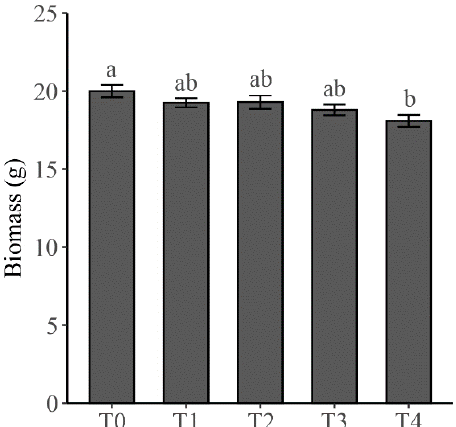
Figure 2. Total mass of soybean plants under different levels of cadmium (Cd) treatment. The levels of Cd treatment were applied as Hoagland solution (50% strength) amended with 0, 1, 10, 100, and 1000 mg·L − 1 CdCl 2 , which are respectively marked as T0, T1, T2, T3, and T4. Different letters indicate significant differences between groups. The error bars denote 1 SE of the mean.